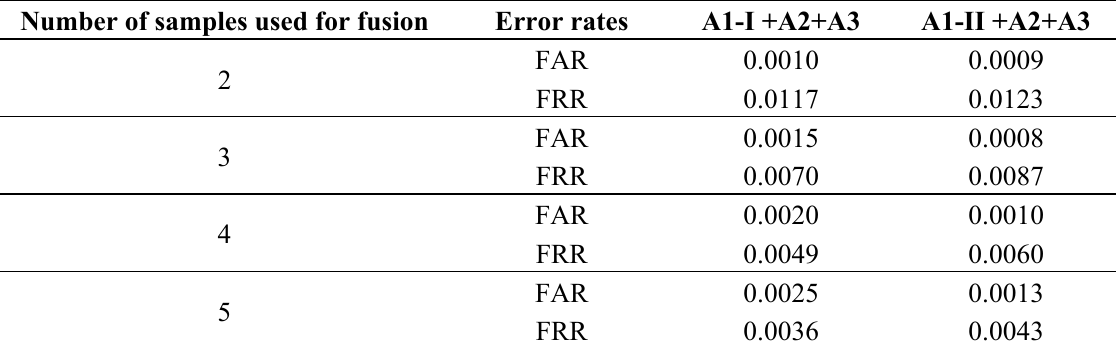
Table 10. Best performance (operation points closest to the performance target FRR ≤ 0.01 @ FAR = 0.001)—multi-sample-instance-algorithm